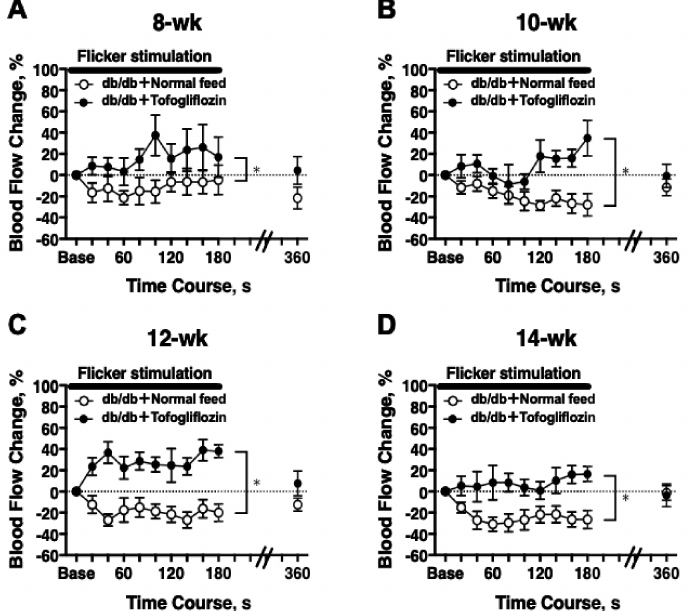
Figure 4. The RBF response to flicker stimulation was longitudinally retained in db/db mice treated with tofogliflozin (db/db + tofogliflozin, n = 6) and blunted in db/db mice fed normal chow (db/db + normal feed, n = 6) from 8 to 14 weeks of age: ( A ) 8 weeks of age; ( B ) 10 weeks of age; ( C ) 12 weeks of age; ( D ) 14 weeks of age. * p < 0.05 between groups analyzed by a repeated-measures ANOVA; solid bar = period of flicker